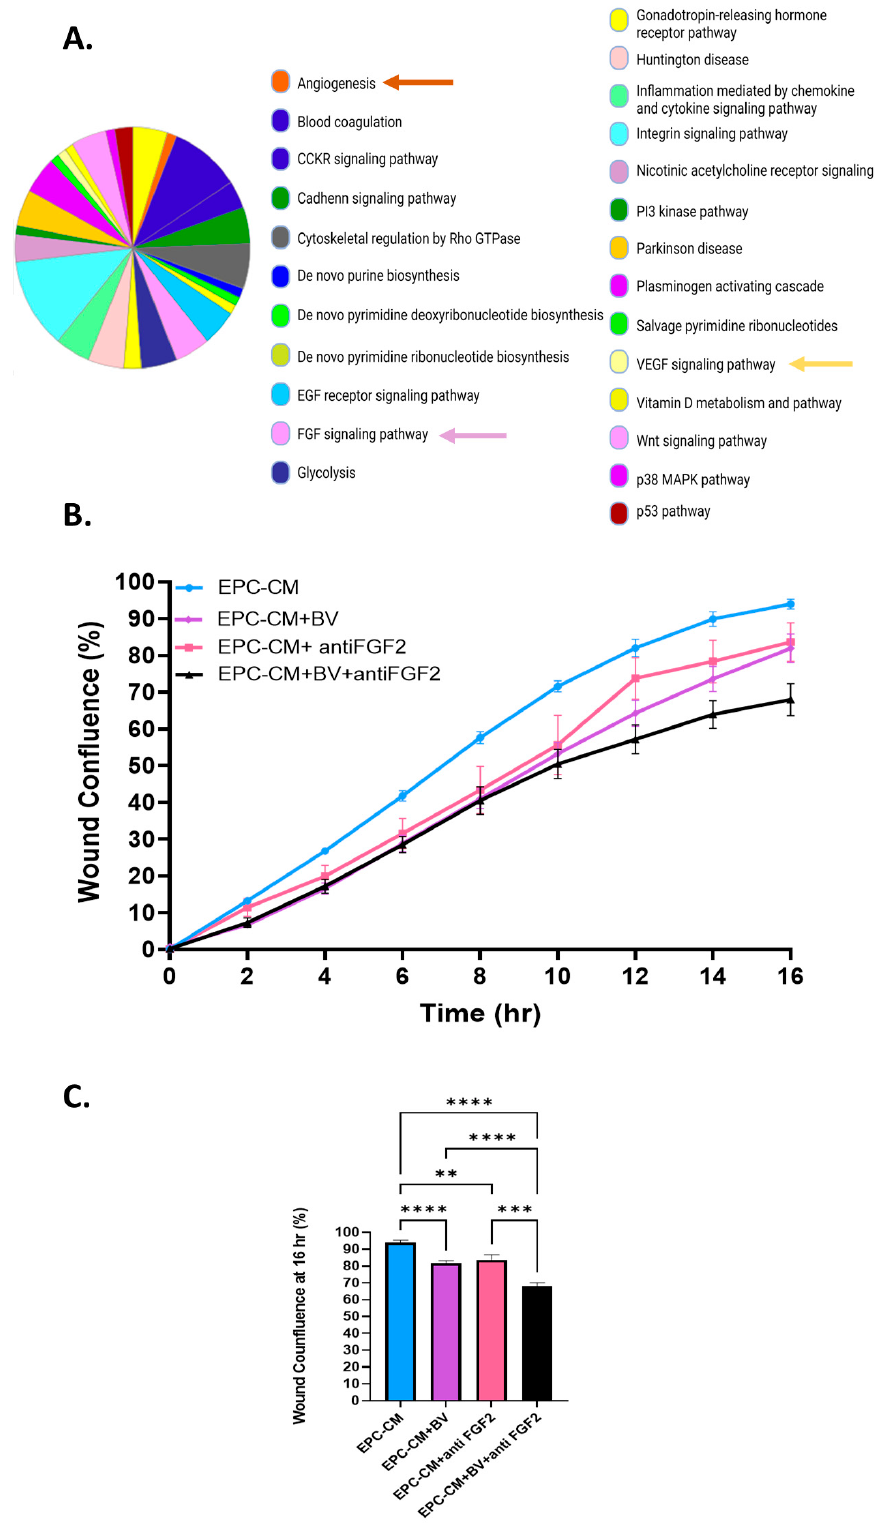
Figure 2. VEGF-A and FGF2 in the EPC-CM influence OS migration. ( A ) EPC-CM protein content. EPC-CM displays an angiogenic profile. CCKR, cholecystokinin receptors; EGF, epidermal growth factor; FGF, fibroblast growth factor; PI3 kinase, phosphoinositide 3 kinase; VEGF, vascular endothe- lial growth factor. ( B ) Migration rate of U2-OS cells cultured with EPC-CM, EPC-CM+ BV (2 mg/mL), EPC-CM+ anti FGF2 (0.08 µ g/mL), and EPC-CM + BV (2 mg/mL) + anti FGF2 (0.08 µ